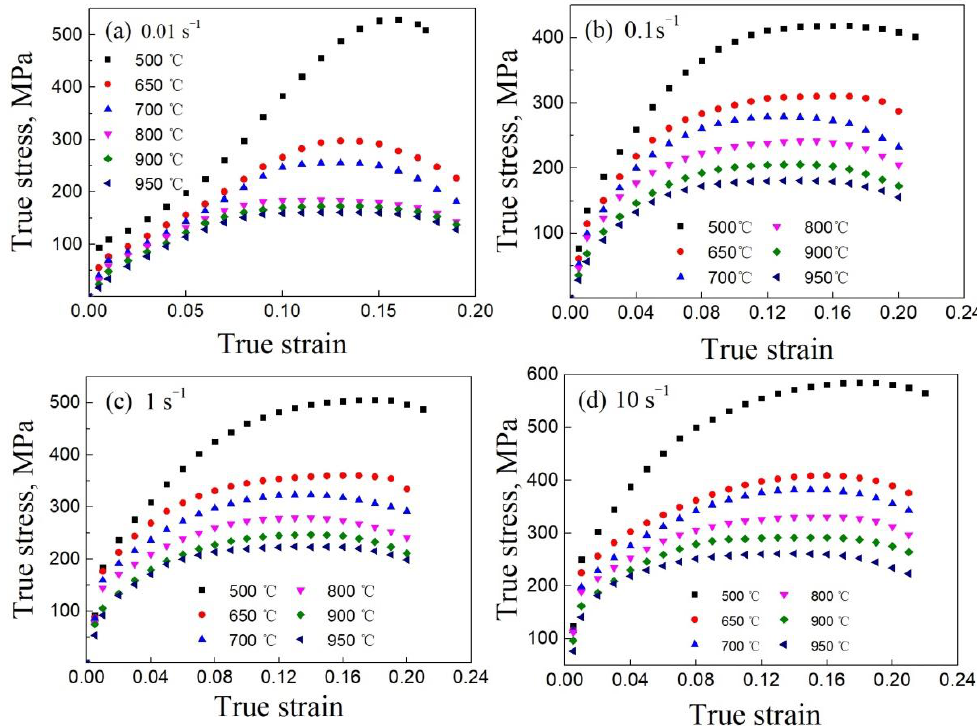
Figure 2. True stresstrue strain curves of the studied steel at strain rates of ( a ) 0.01 s −1 , ( b ) 0.1 s −1 , ( c ) 1 s −1 and ( d ) 10 s −1 . ( c ) 1 s − 1 and ( d ) 10 s − 1